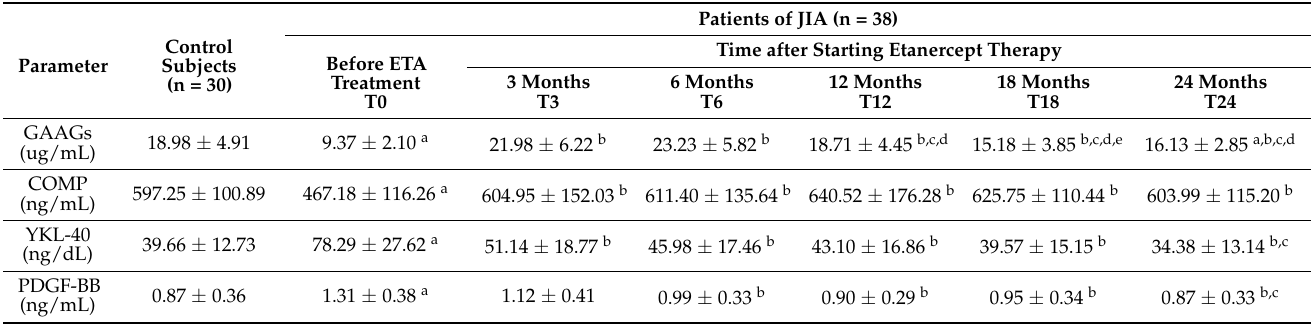
Table 2. The distribution patterns of plasma GAAGs, COMP, YKL-40, and PDGF-BB in the healthy individuals (control subjects) and JIA